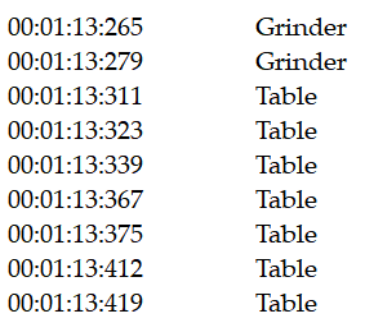
Figure 6. Example of the collected raw eye tracking data.